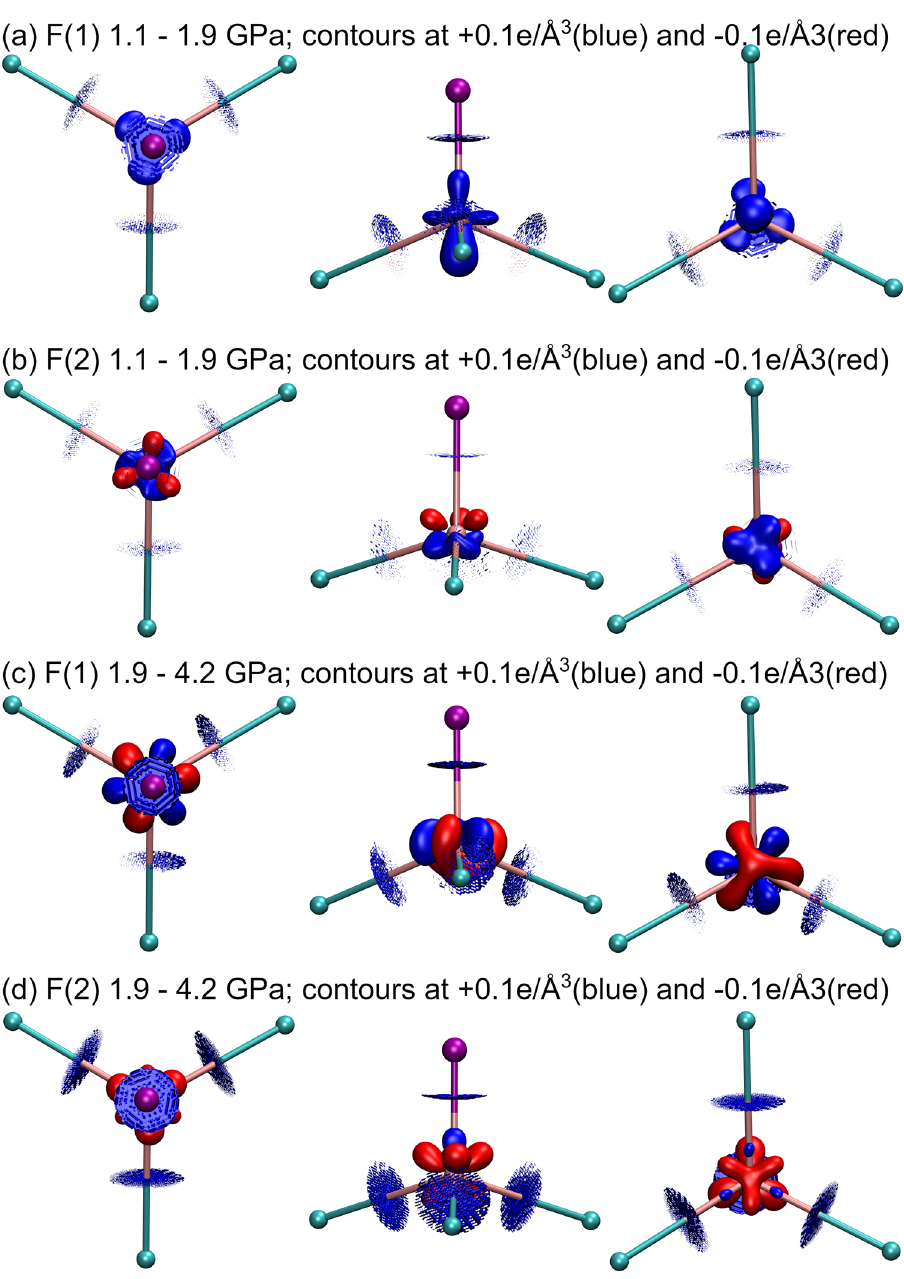
Figure 4. Differences in total electron densities ρ at F anions illustrated at the ± 0.1e/A 3 isovalues: the total electron density at a higher pressure ρ(P in GPa) is subtracted from the total electron density at lower pressure ρ(1.1)- ρ(1.9) for F(1) ( a ), ρ(1.1)- ρ(1.9) for F(2) ( b ); ρ(1.9GPa)- ρ(4.2GPa) for F(1) ( c ); ρ(1.9GPa)- ρ(4.2GPa) for F(2) ( d ). Isovalues at + 0.1e/Å 3 (blue) and − 0.1e/Å 3 (red). Colours of neighbouring ions: cyan for calcium and violet for